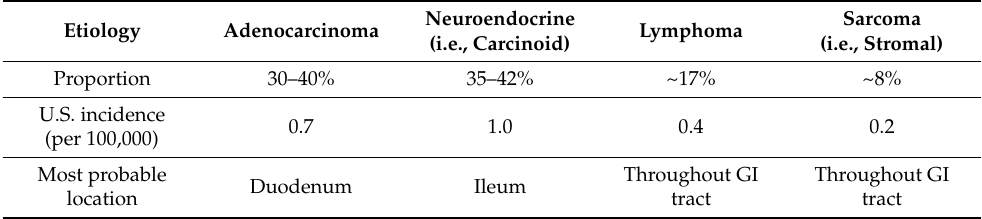
Table 1. Small intestinal cancer etiologies and